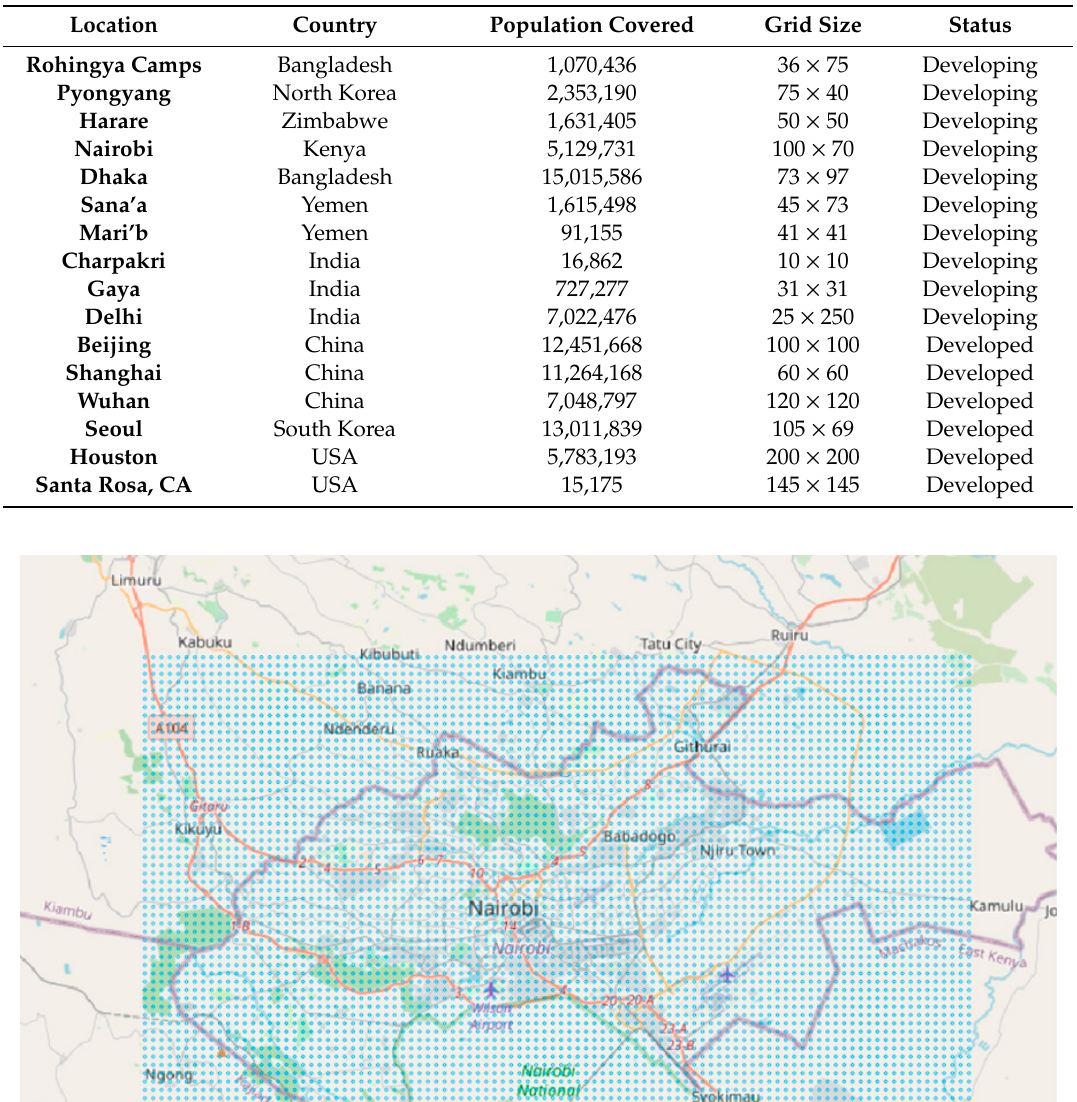
Table 1. DNB temporal profiles extracted for this study.